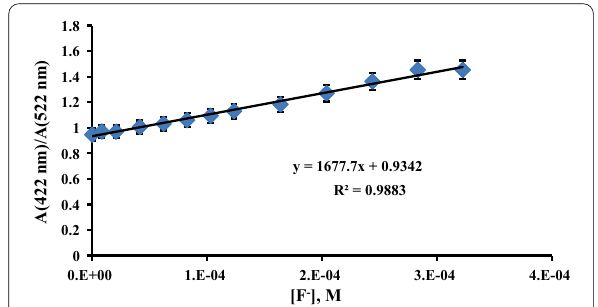
Fig.4 Calibration plot for the sensing of F